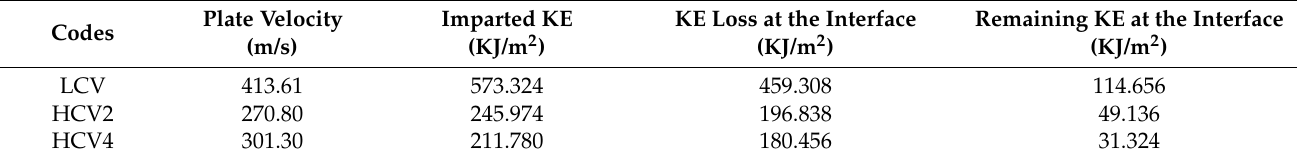
Table 4. Estimated kinetic energy (KE) imparted to a flyer Mo plate in the explosive welded clads and related values.